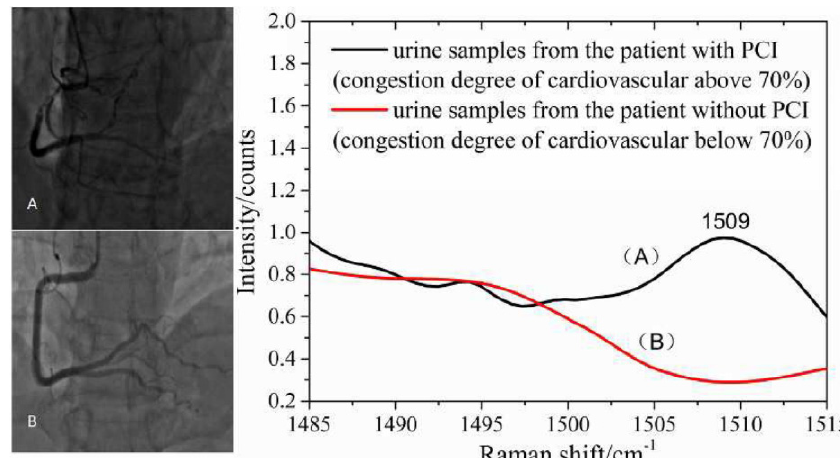
Figure 4. The SERS spectra of human urine could provide valuable information for noninvasive and prospective diagnosis of suspected cases of coronary heart disease. ( A ) urine samples from the patient with PCI (congestion degree of cardiovascular above 70%; ( B ) urine samples from the patient without PCI (congestion degree of cardiovascular below 70%). Picture reproduced with permission from “ Noninvasive and prospective diagnosis of coronary heart disease with urine using surface-enhanced Raman spectroscopy ”, Yang, H. et al., Analyst, 2018